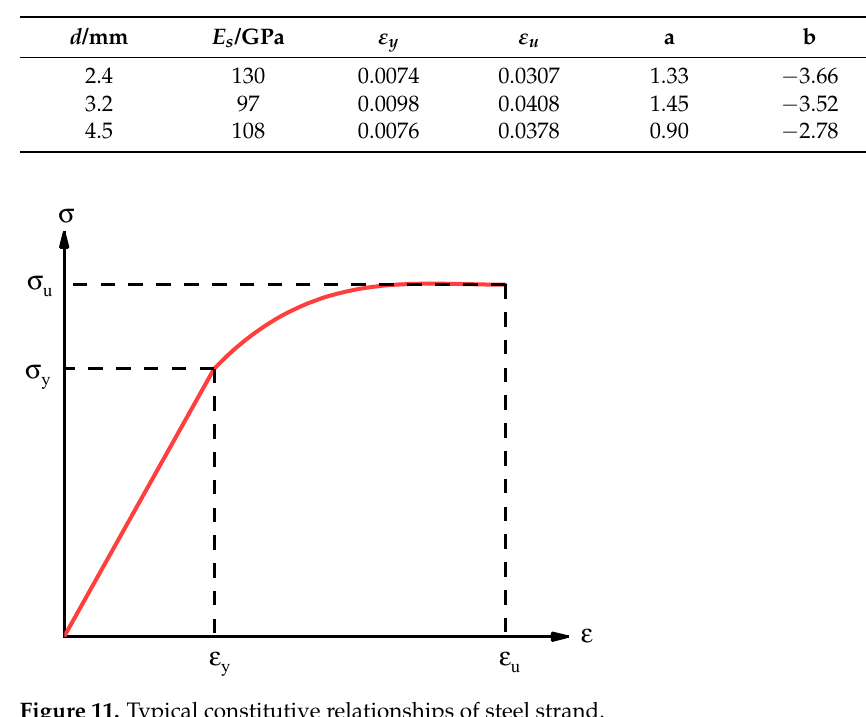
Figure 11. Typical constitutive relationships of steel strand.